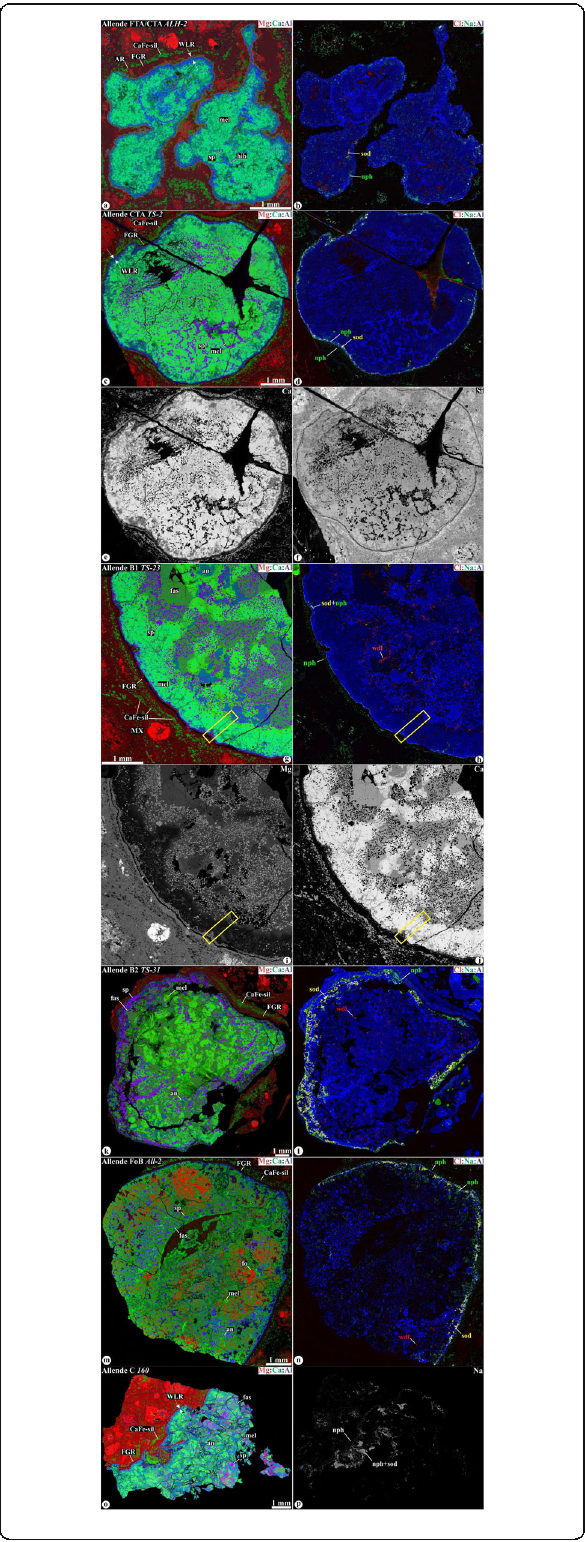
Fig. 1 Combined x-ray elemental maps in ( a , c , g , k , m , o ) Mg (red), Ca (green), and Al (blue), ( b , d , h , l , n ) Cl (red), Na (green), and Al (blue) and elemental maps in ( e , j ) Ca, ( f ) Si, ( j ) Mg, and ( p ) Na of representative samples of coarse-grained CAIs from the CV3 carbonaceous chondrites Allende studied: ALH2 (FTA/CTA), TS2 (CTA), TS23 (B1), TS31 (B2), Al-2 (FoB), and 160 (C). Regions outlined in “ g − j ” are shown in detail in Fig. X. All CAIs are surrounded by Wark- Lovering rims (WLR), fine-grained matrix-like rims (FGR), and a layer of Ca,Fe-rich silicates (CaFe-sil). Nepheline and sodalite are concentrated in the peripheral portions of CAIs. Abundant nepheline grains occur also in fine-grained matrix-like rims. Wadalite/adrianite are found exclusively in cores of Type B CAIs (high Cl signal in b comes from epoxy). fas = Al,Ti-diopside; mel = melilite. Hereafter: abbreviations of secondary minerals are listed in Table